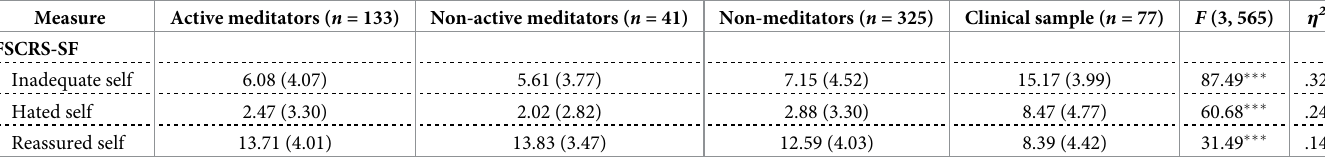
Table 5. Means, standard deviations, and one-way analyses of variance in FSCRS-SF subscales.